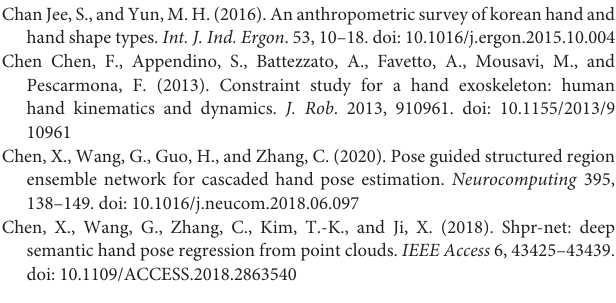
AE with no 3DJE with correction (mm) correction ( ◦ ) correction